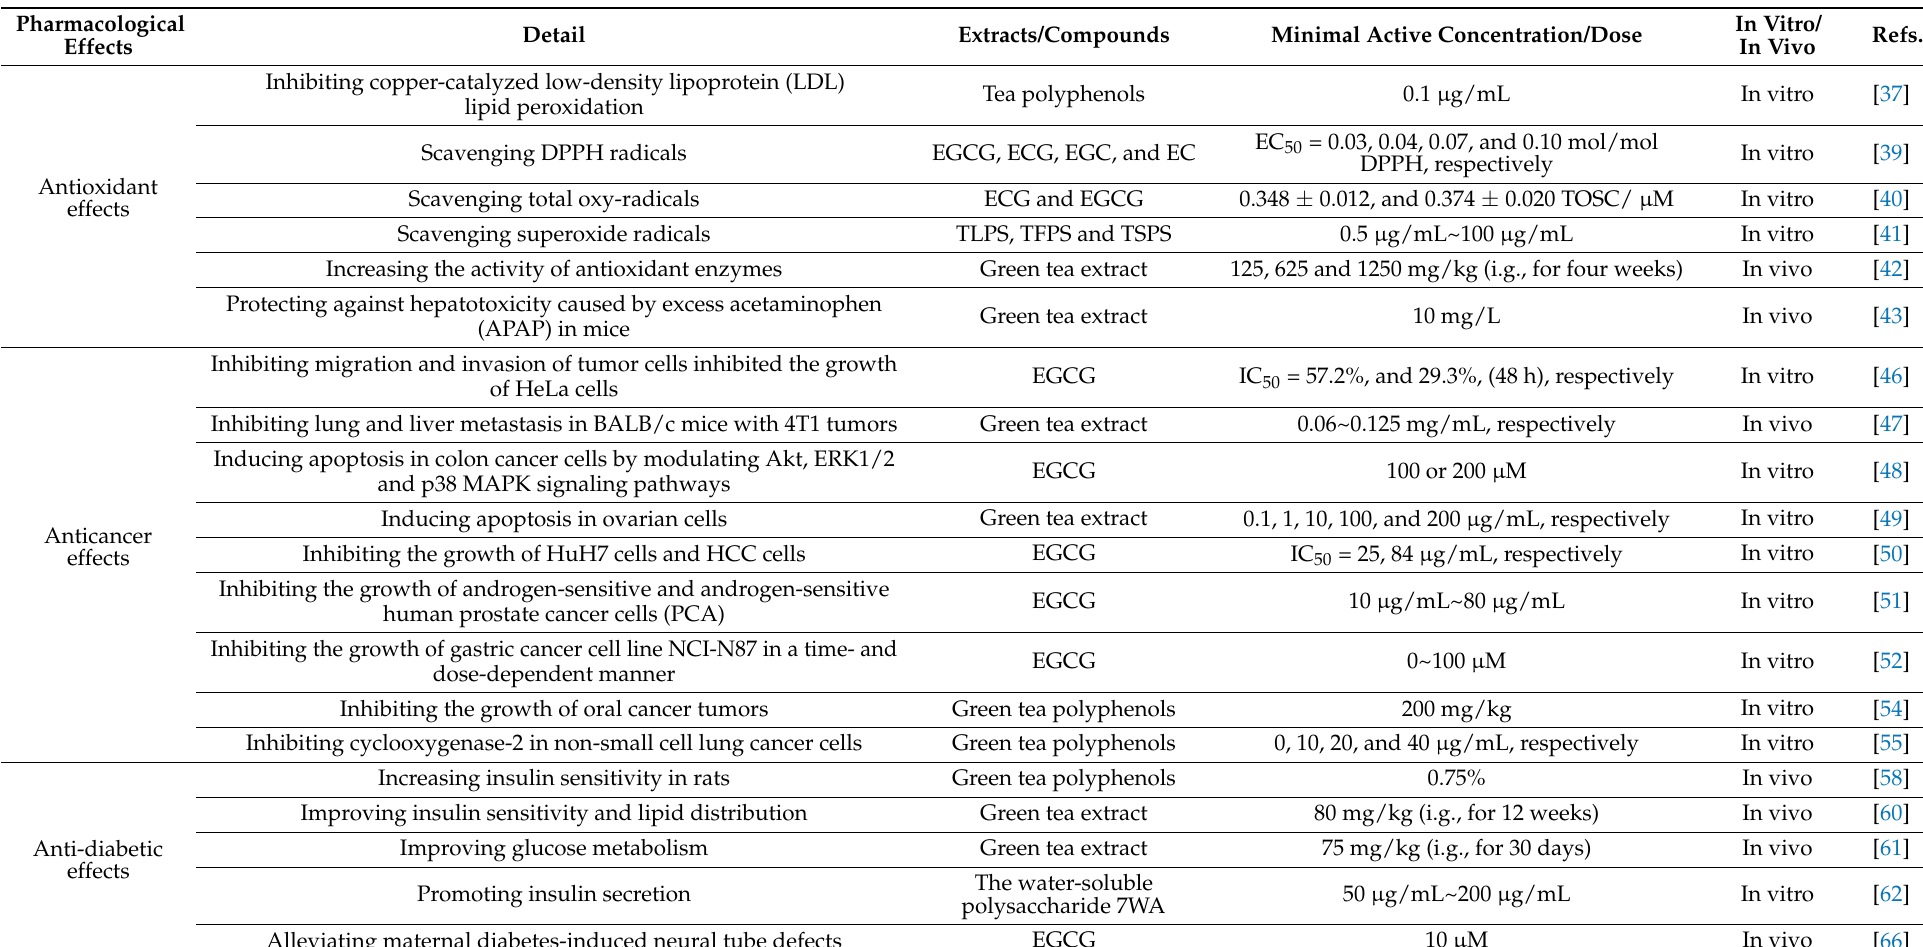
Table 1. Pharmacological effects of green